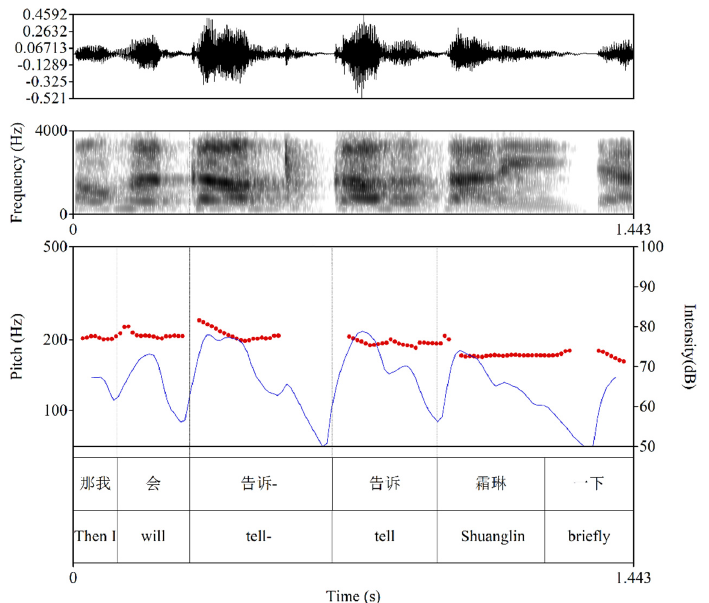
Figure 7. Waveform, spectrogram, pitch contour, and intensity of line 03 in Ex 15.